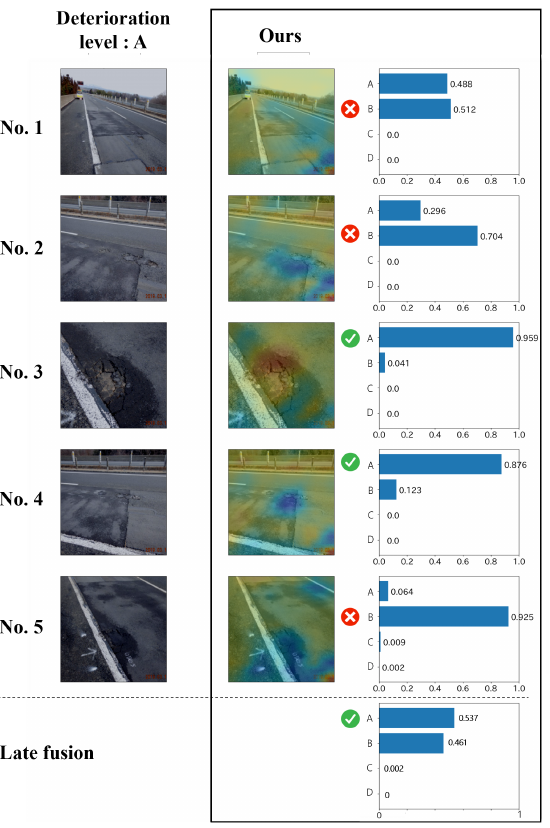
Figure 12. The example of the case that many images in the record are not necessarily related to the